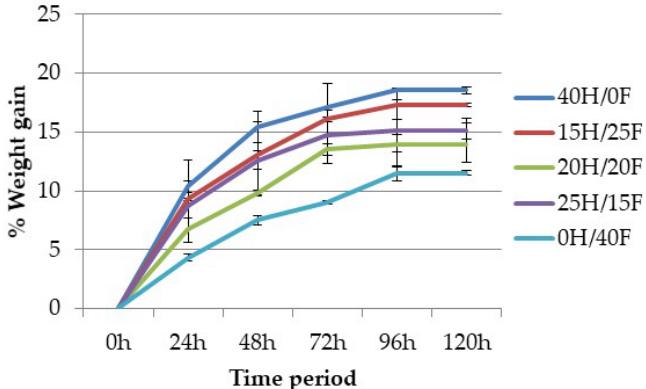
Figure 10. Percentage weight gain vs. time period for hemp and flax composites.